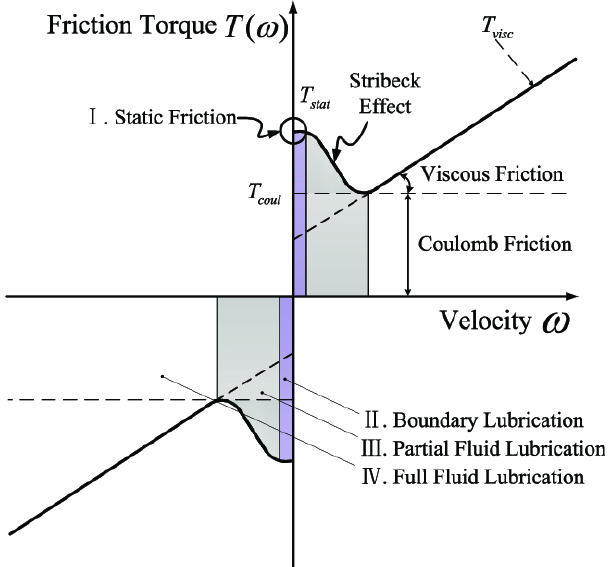
Figure 2. Qualitative representation of the friction